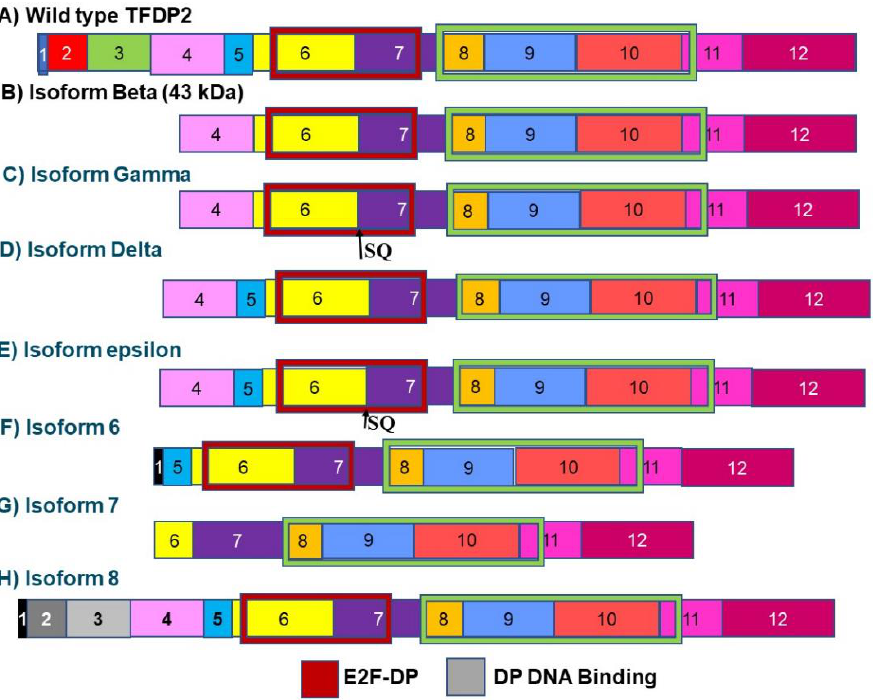
Figure 4. ( A – H ) Isoforms of TFDP2. The TFDP2 transcription factor is known to be expressed at high levels in HNSCC and is alternately spliced to give rise to 8 isoforms. Isoform 7 is missing the E2F/DP dimerization domain. This isoform can block E2F associated transcription and, therefore, inhibit cell cycle progression. Although the precise role of these isoforms in HNSCC is unknown, the high expression levels of the wild-type variant in HNSCC imply that isoform 7 may serve as a negative regulator of cancer progression. The blocks in this figure represent the different exons making up each isoform. The size of the boxes indicates the relative size of the exons.